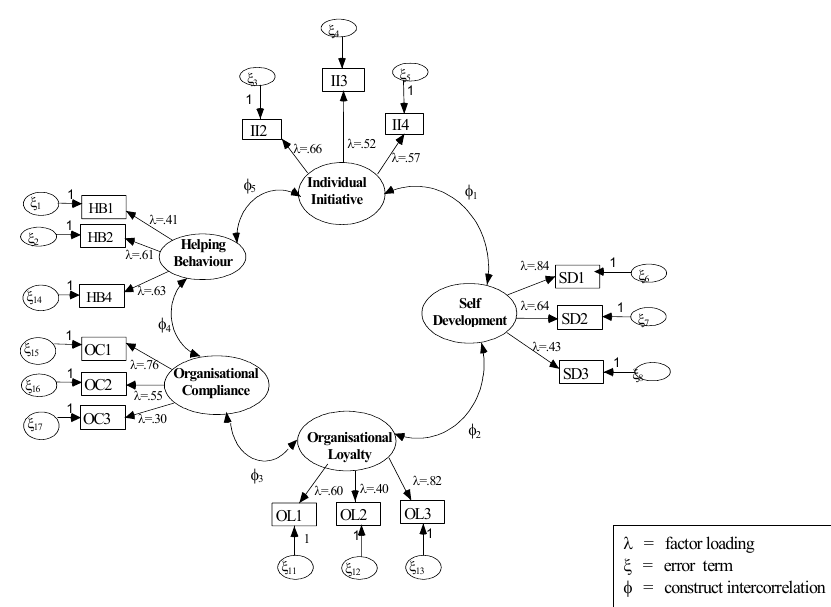
Figure 2: Revised confirmatory factor analysis model for the dimensions of extra-role performance